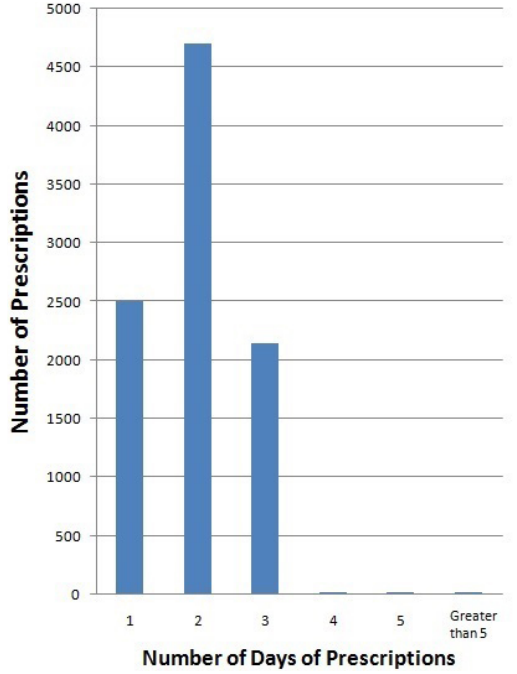
Figure 3 . Breadkdown of opioid prescriptions into the number of days they were written